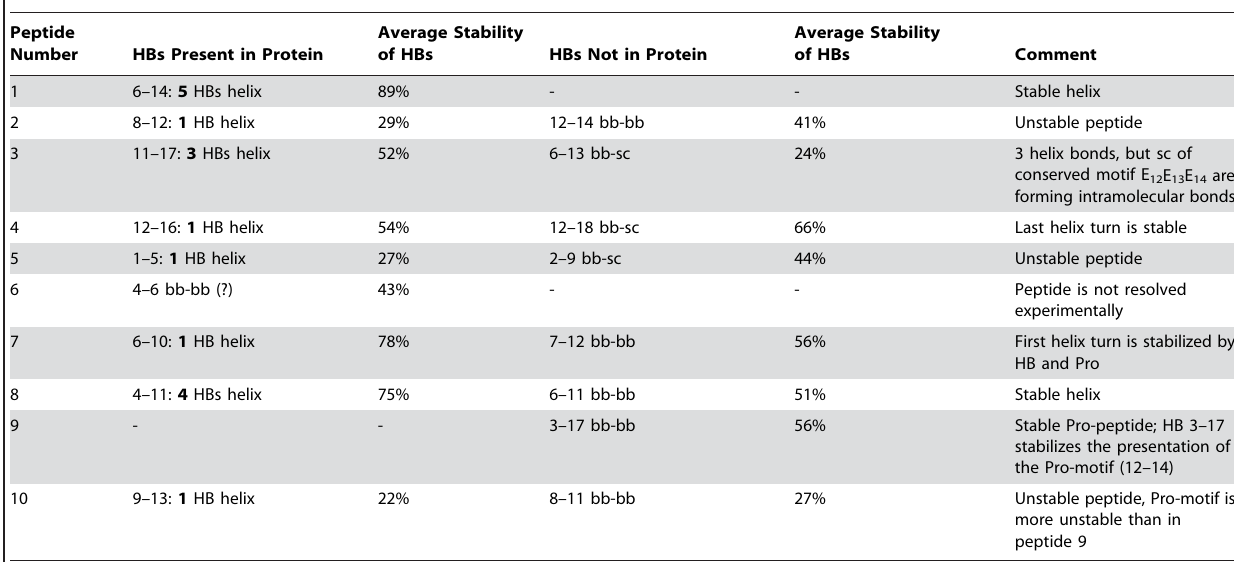
Table 1. Proteinlike and peptide-unique motifs stabilized by hydrogen bonds (HBs) (error 10%).